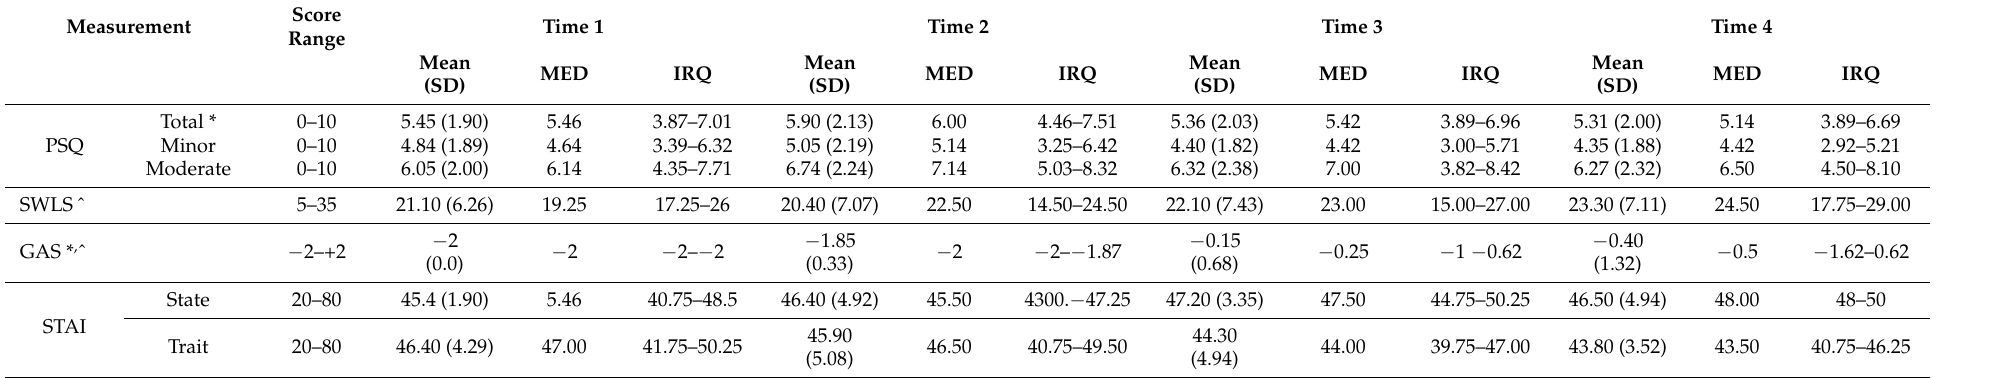
Table 3. Mean (SD), median, and IRQ of study measures (PSQ, SWLS, GAS, STAI) in the four measurements